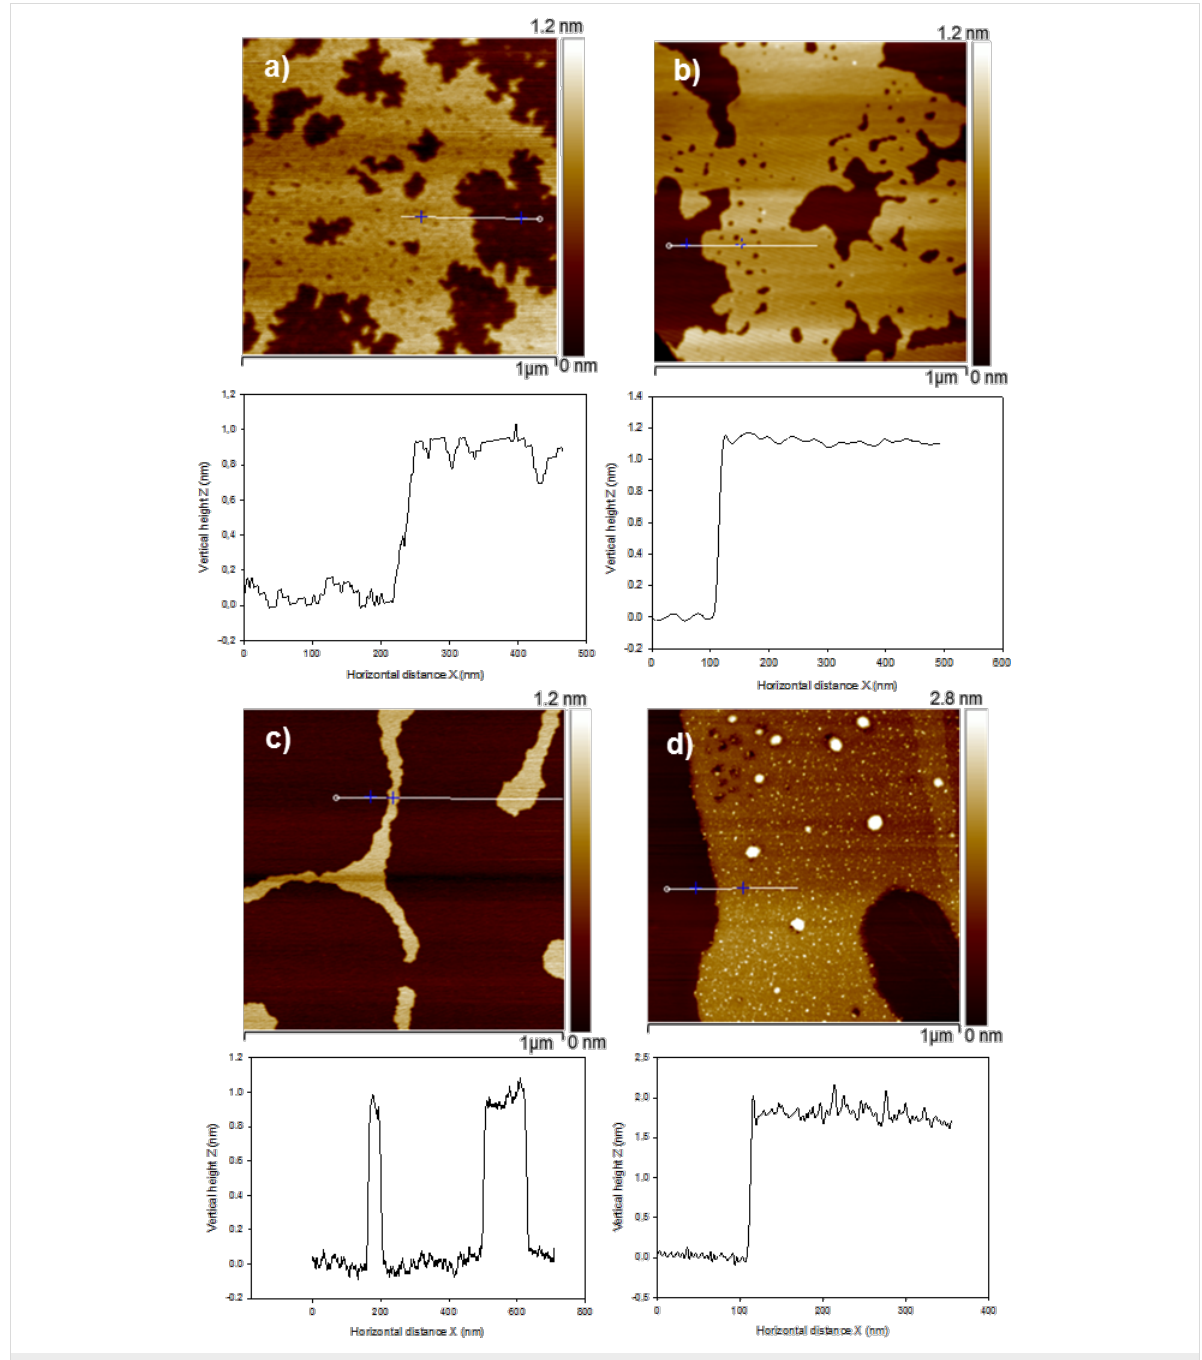
Figure 1: TM-AFM height images of Keggin POM (a,b), and Wells–Dawson POM (c,d) deposited on mica and HOPG surfaces, respectively. The corresponding cross-section analyses taken along the white lines are shown below each image.